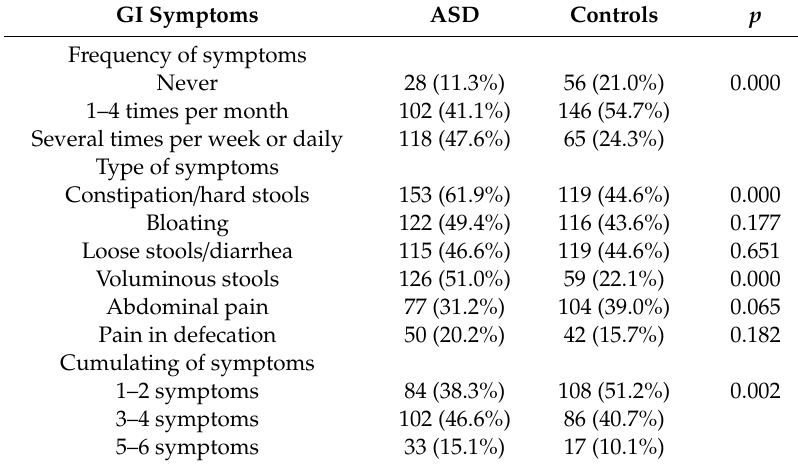
Table 3. Frequency and types of gastrointestinal (GI) symptoms in children and adolescents with autism spectrum disorders (ASD) and controls ( number , % of total).